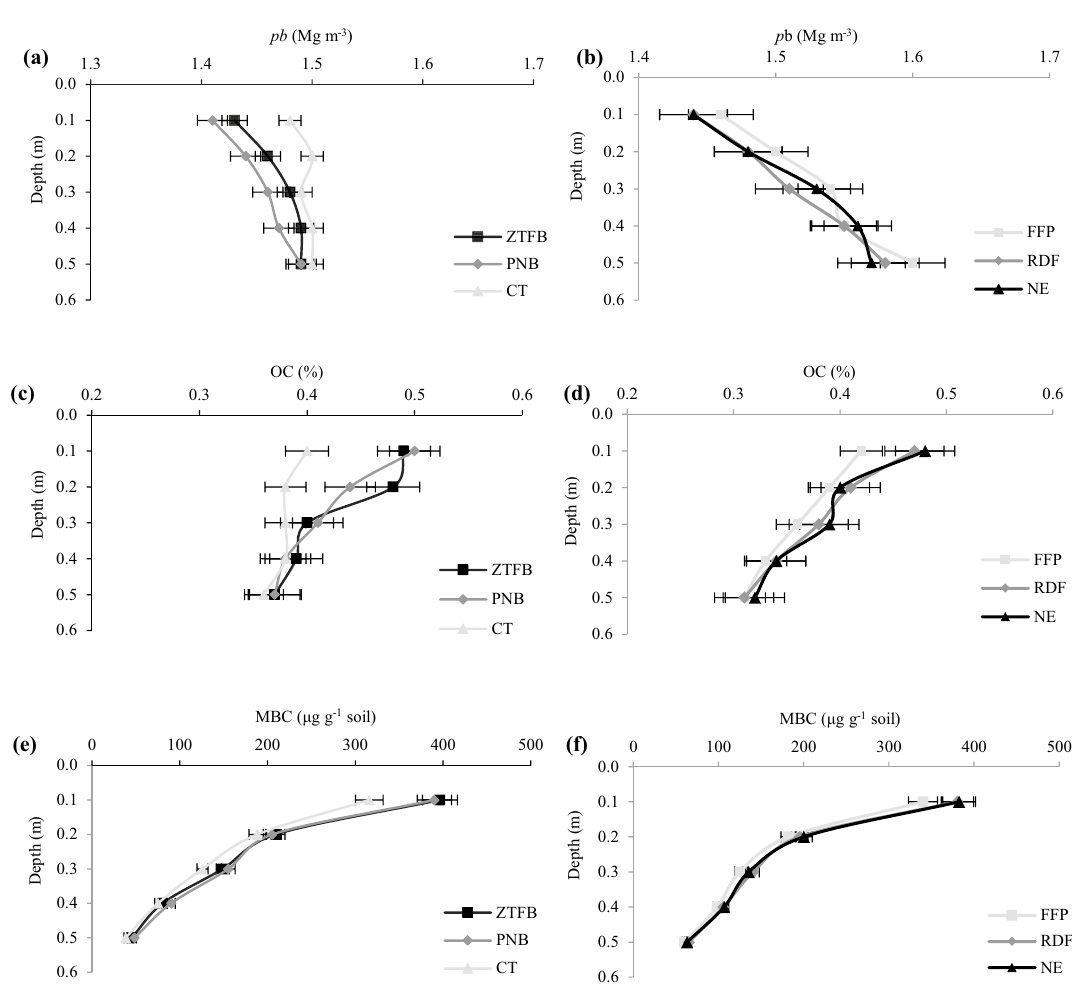
Figure 5. Soil p b ( a , b ), OC ( c , d ) and MBC ( e , f ) under the CA-based CEP and nutrient management after 7th season maize in the maize–chickpea rotation. The horizontal bars indicate the LSD at p =